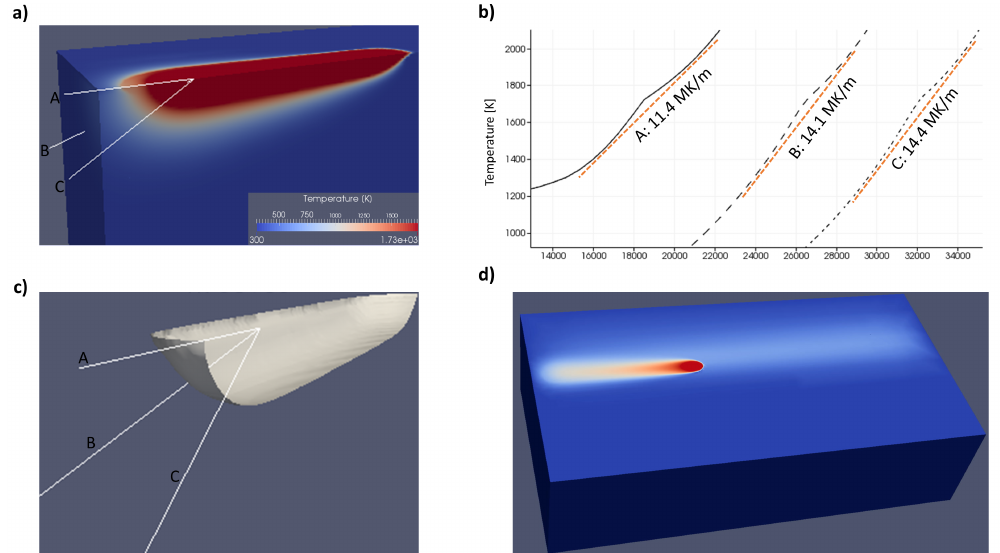
Figure 3. Example of the temperature profile for a computationally efficient large-scale heat-transfer model. The top-left panel ( a ) shows the temperature distribution in a single line scan, top-right shows ( b ) the corresponding thermal gradients along lines A, B, C relative to the trailing edge. Bottom-left ( c ) shows the corresponding liquidus isosurface of the melt pool. Bottom-right ( d ) shows the temperature distribution under a zig-zag scanning